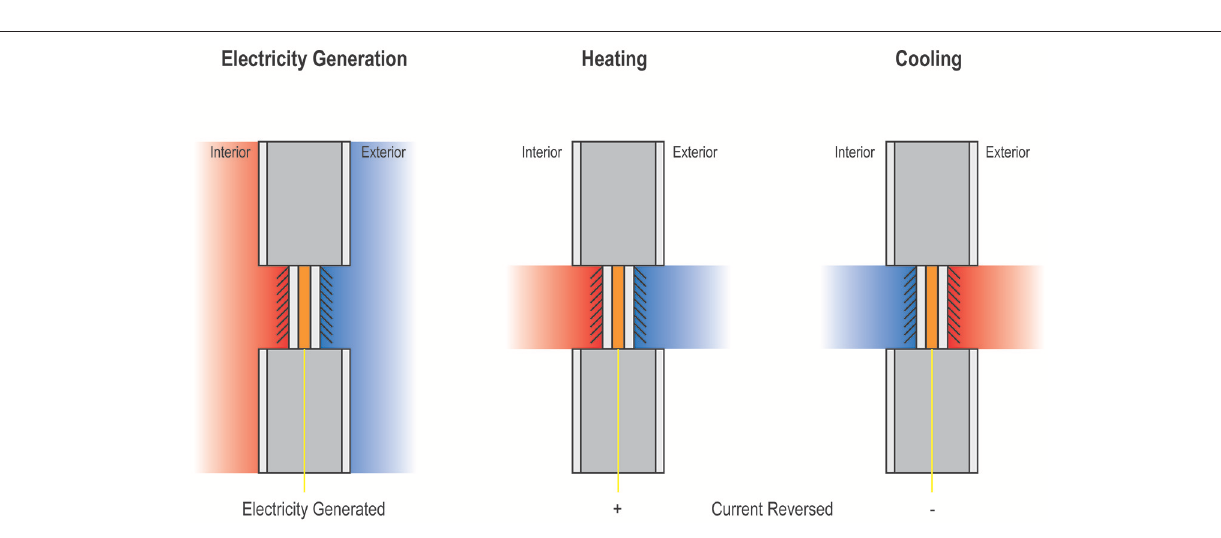
FIGURE 2 | Potential use of TE materials in exterior walls for energy generation, heating and